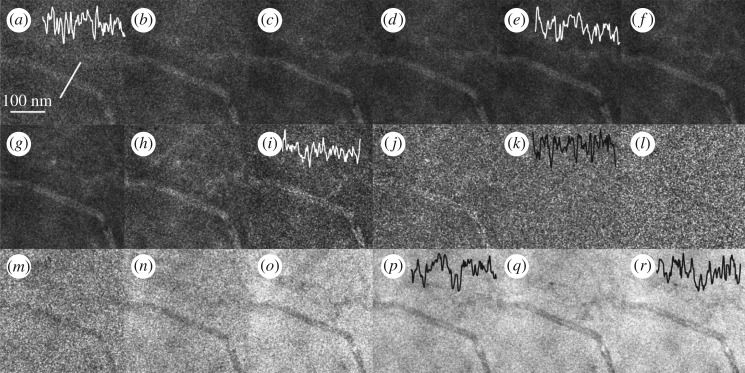
STEM images of a 1 µm thick section of a PNC acquired with 52 e– Å–2 at various inner collection angles βin (in mrad) with the intensity profile across the CNT shown as the inset: (a) 55.26, (b) 42.36, (c) 33.44, (d) 26.47, (e) 21.91, (f) 17.17, (g) 14.12, (h) 11.34, (i) 8.95, (j) 7.14, (k) 5.53, (l) 4.54, (m) 3.53, (n) 2.82, (o) 2.23, (p) 1.76, (q) 1.41 and (r) 1.02.